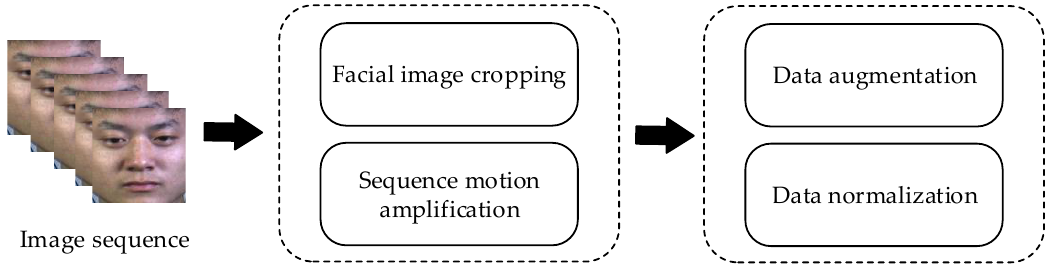
Figure 6. Steps of data pre-processing.